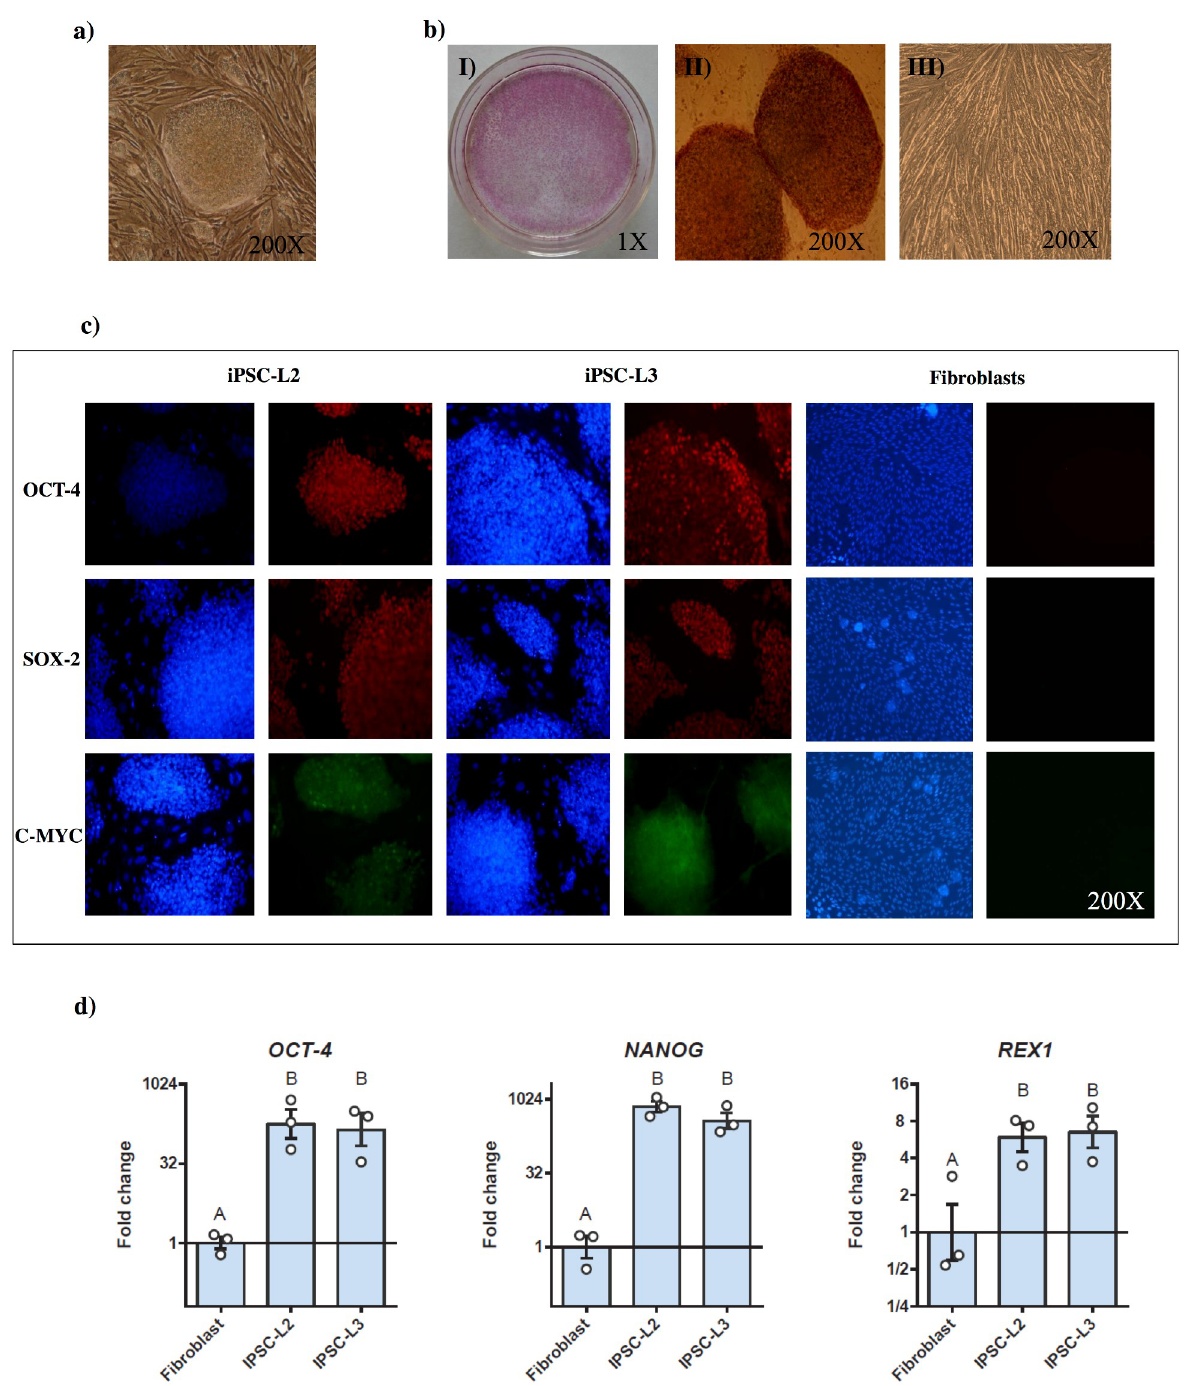
Fig 1. Pluripotent characterization of two horse iPSC lines, L2 and L3. a) A representative colony of equine iPSCs 2 weeks after reprogramming. b) Alkaline phosphatase activity analysis of the L2 iPSC line, I) A 60 mm petri dish full of iPSC colonies observed in pink; II) Two iPSC colonies with high alkaline phosphatase activity; III) Horse fibroblasts negative for alkaline phosphatase activity. c) Inmunostaining of both iPSC lines and horse fibroblasts with the pluripotent markers OCT-4, SOX-2 and c-MYC. In blue nucleous are stained with DAPI d) RT-qPCR analysis comparing the expression of OCT-4 , NANOG and REX-1 among the original fibroblasts and the L2 and L3 iPSC lines. Results are presented as means ± SEM (n = 3). Data were relativized to fibroblasts. Different letters indicate significant differences (p < 0.05).